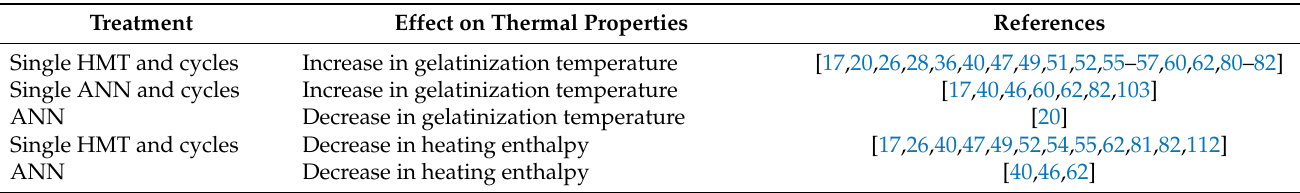
Table 5. Several studies related to the effect of hydrothermal modifications on thermal